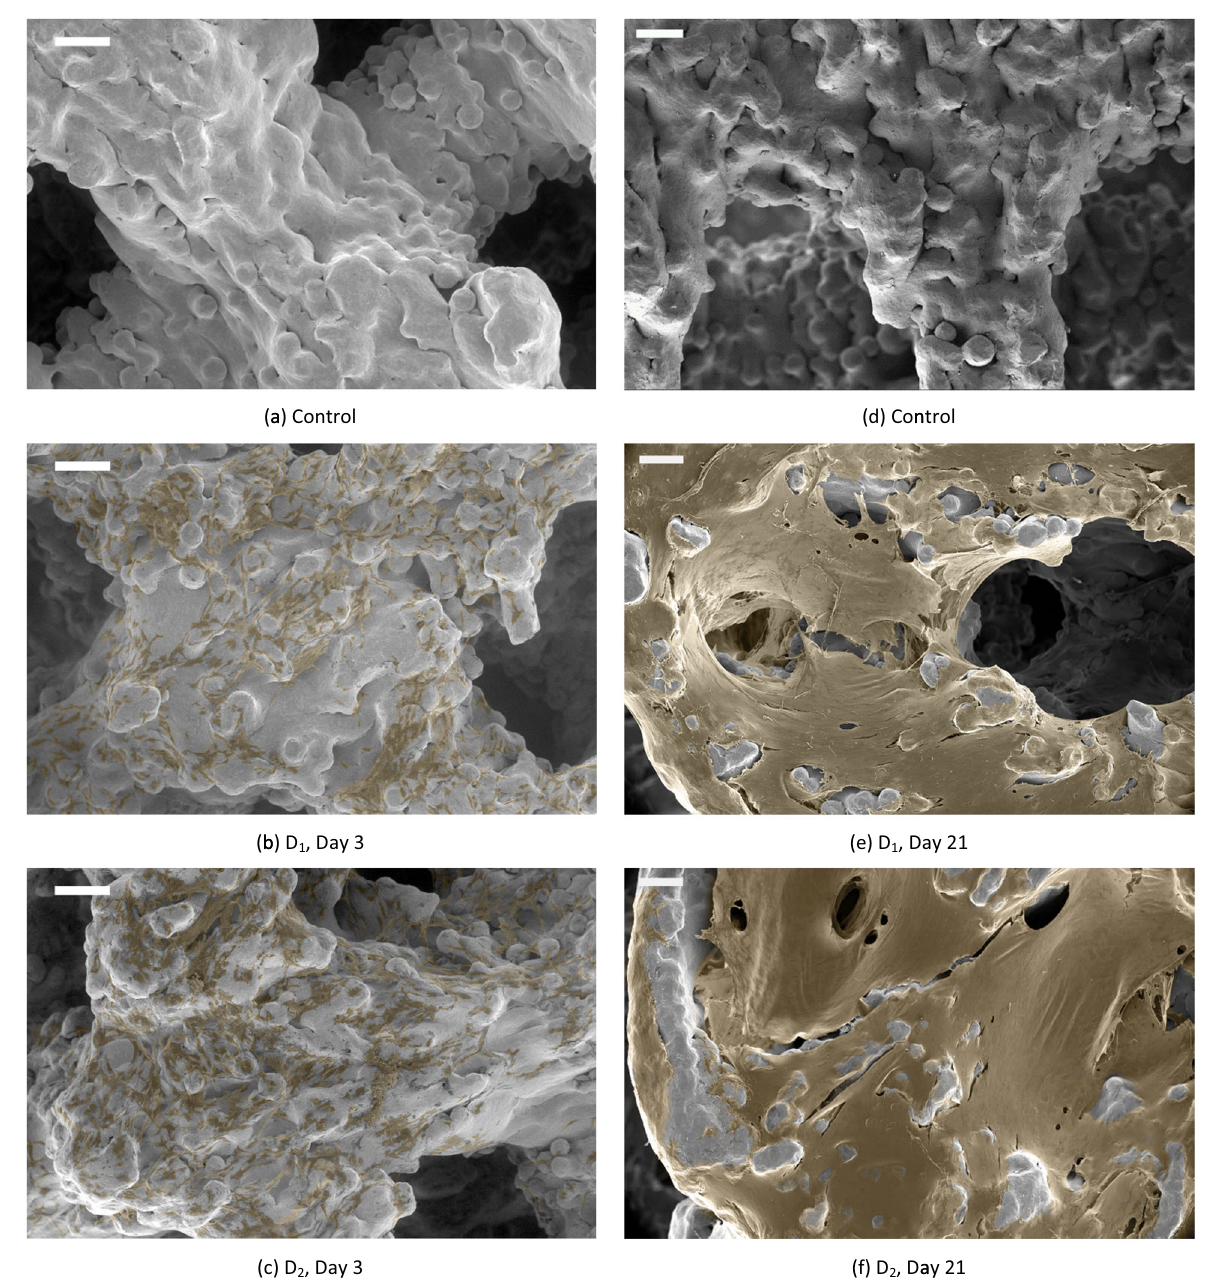
Fig. 4 Cell adhesion and matrix development from two donors as revealed by ESEM ( a , b , c ) and SEM ( d , e , f ) imaging. Adhesion can be seen in the ESEM at day 3 ( b and c ), where cells are highlighted